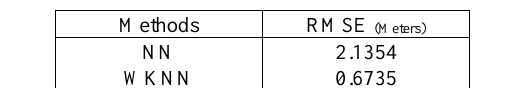
Table 3. RMSE for positioning methods in the second scenario